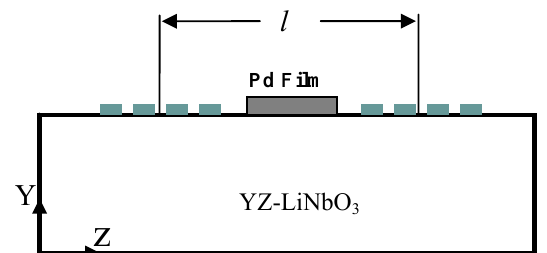
Figure 5. SAW sensor configuration for hydrogen